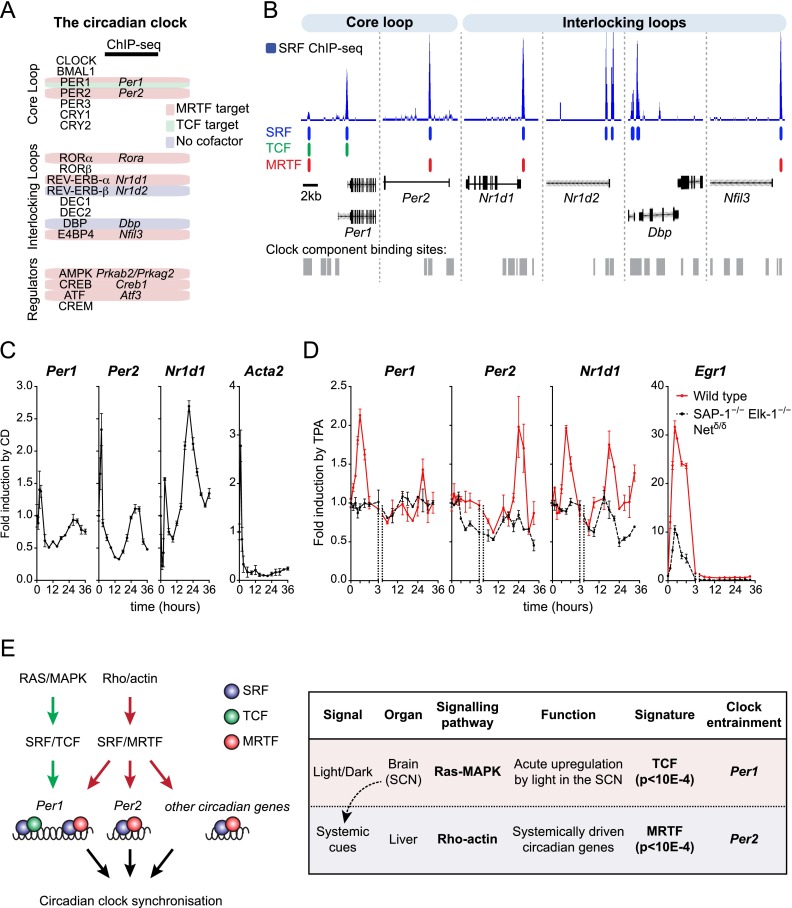
SRF and MRTF can both reset the circadian clock. (A) SRF targets among circadian clock circuits (for discussion of regulatory loops, see Koike et al. 2012). (B) SRF, MRTF, and TCF ChIP-seq peaks are shown below in blue, red, and green, respectively, aligned with binding sites in the liver for the clock genes Per1 and Per2 (core loop components) and Nr1d1, Nr1d2, Dbp, and Nfil3 (interlocking loop components) (Koike et al. 2012), shown in gray. (C) Clock resetting by MRTF activation. NIH3T3 cells were treated with 2 µM CD for 2 h followed by washout; transcripts were quantified by qRT–PCR over 36 h. For serum stimulation kinetics, see Supplemental Figure S7C. (D) Clock resetting by TCF activation. Wild-type and SAP-1−/− Elk1−/− Net∂/∂ MEFs were treated with TPA, and transcripts were quantified by qRT–PCR. (E) Circadian clock synchronization by MRTF- and TCF-linked SRF signaling.